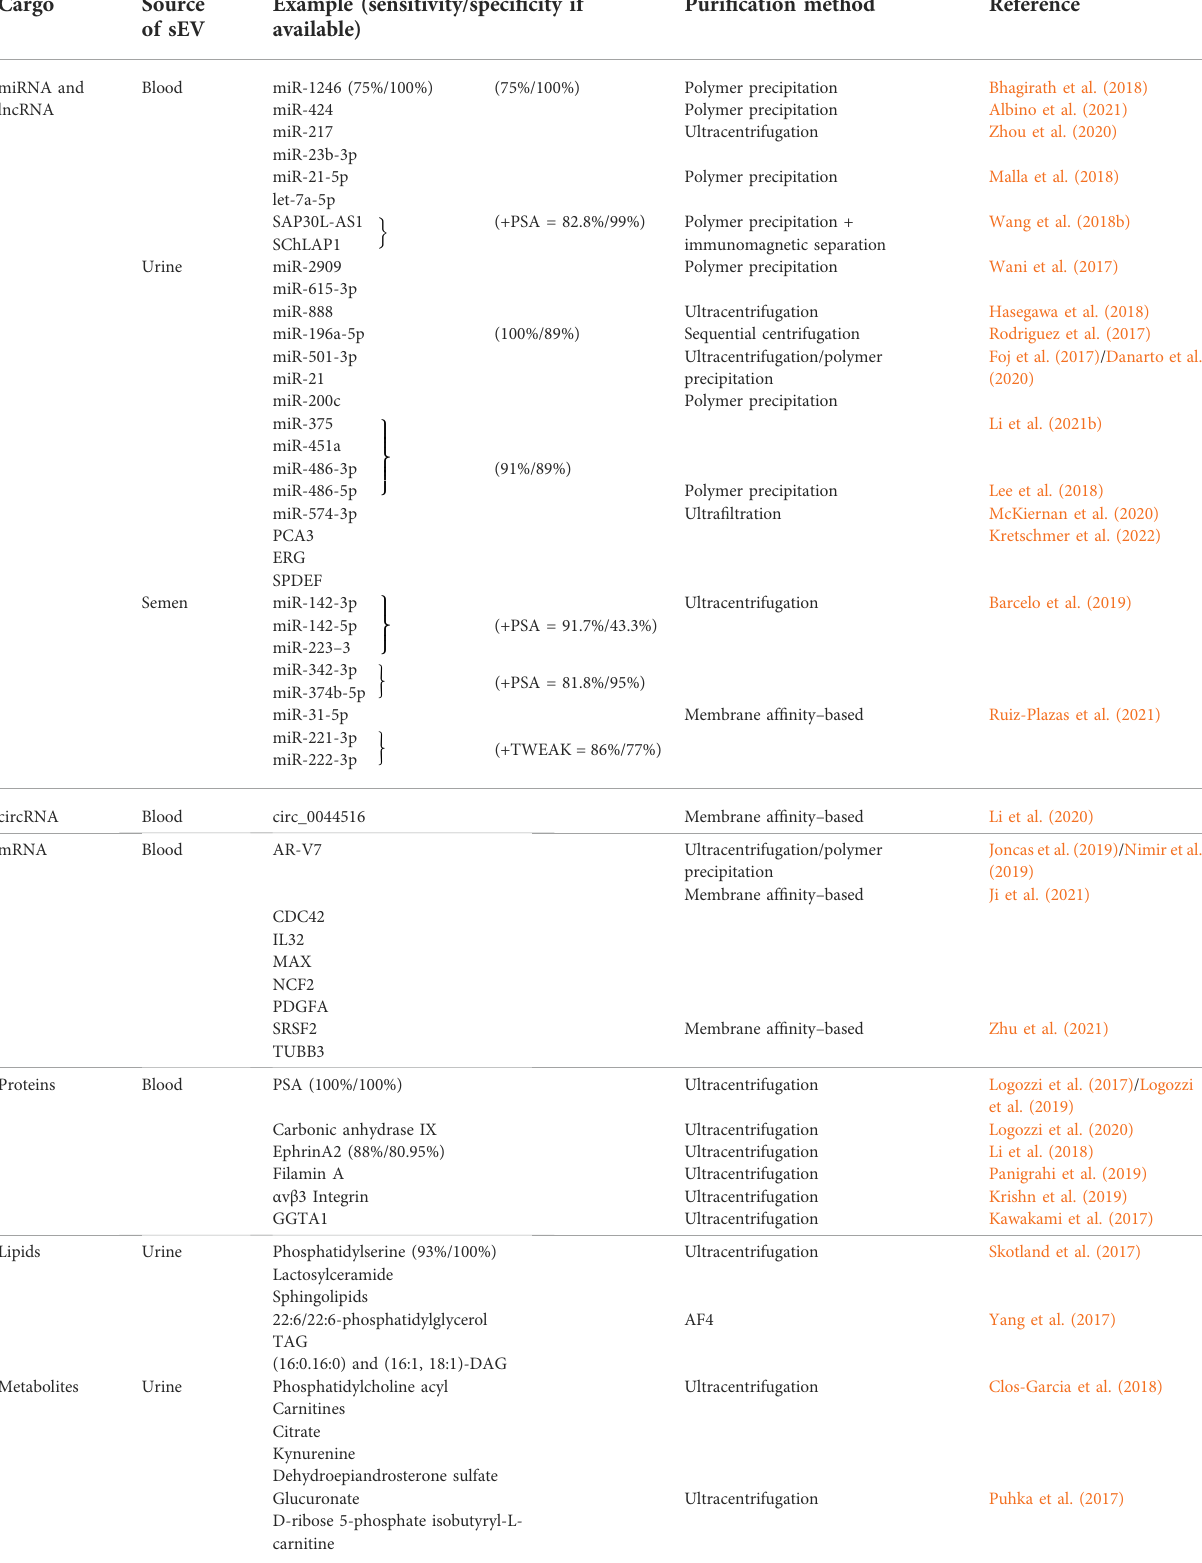
TABLE 1 Summary of the recently evaluated small extracellular vesicle cargo as potential biomarkers for prostate carcinomas. sEVs – small extracellular vesicles, miRNA – microRNA, mRNA – messenger RNA, circRNA – circular RNA, lncRNA – long non – coding